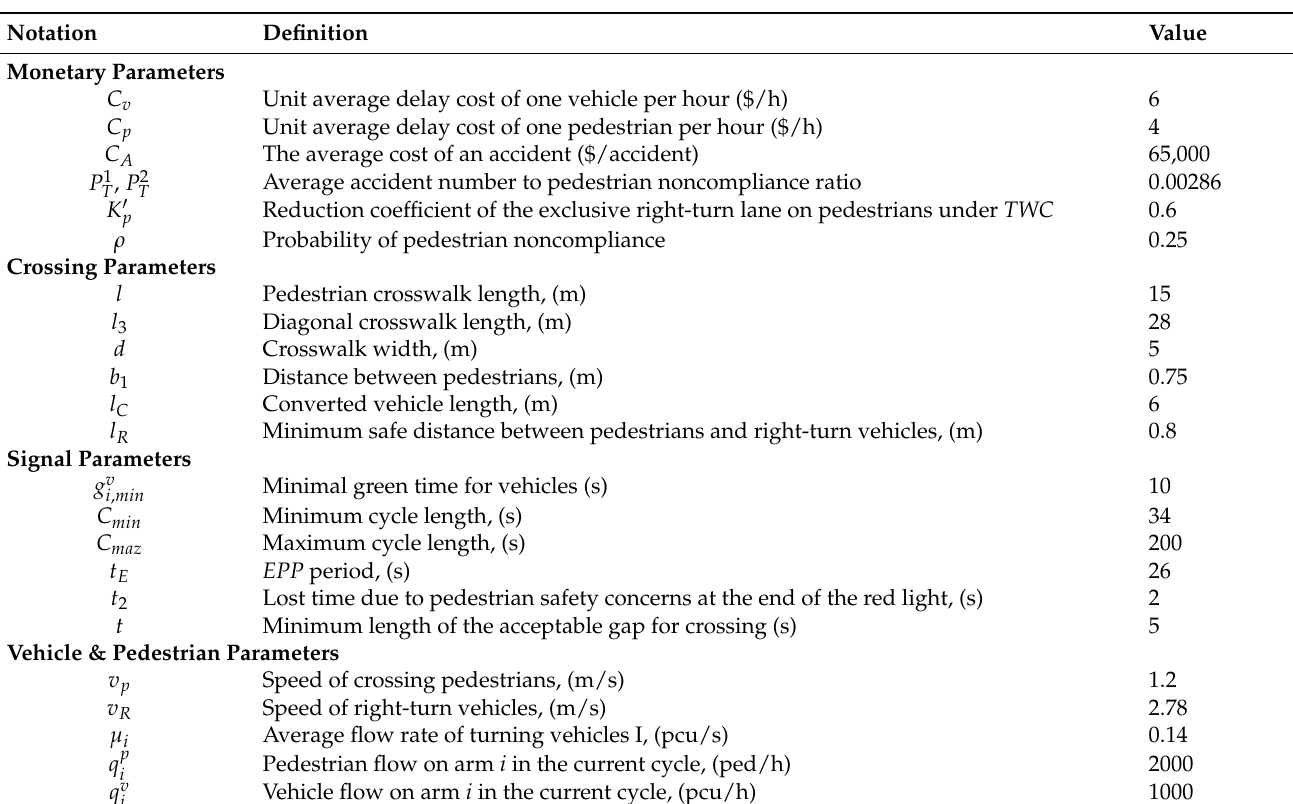
Table 1. Parameters in model